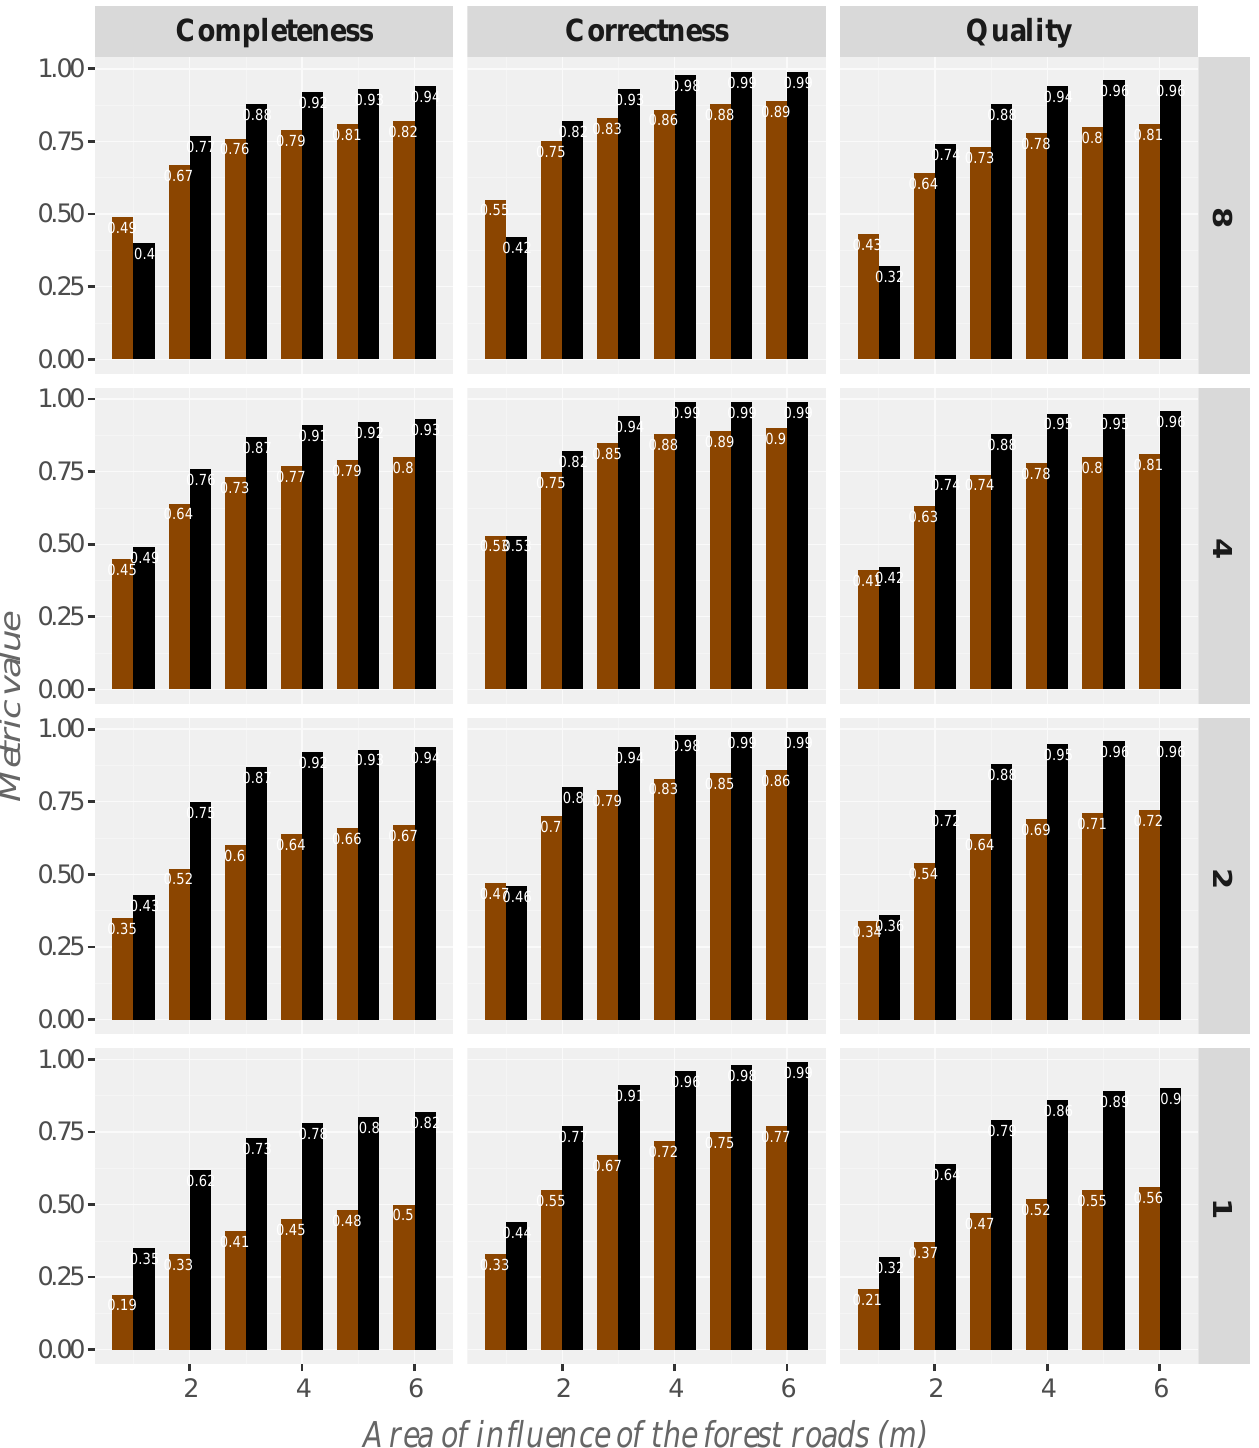
Figure 13. Results of completeness, correctness and quality for point clouds with densities 8, 4, 2 and 1 point/m 2 and different sizes of influence area of the forest roads (paved roads are shown in black and the dirt roads in